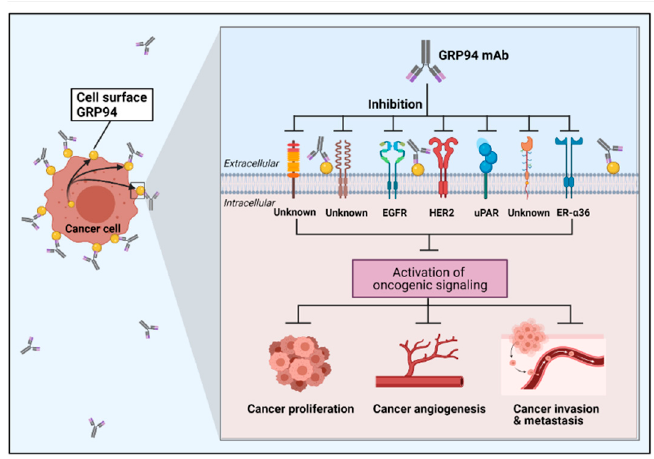
Figure 3. Schematic representation of cancer cell surface GRP94-targeting antibody, with its patho- logical role in the cancer microenvironment. GRP94 is highly expressed on the cancer cell surface. Several receptors are known for interacting with cell surface GRP94, and they facilitate cancer de- velopment by activating oncogenic signaling. So far, EGFR, HER2, uPAR, and ER- α 36 are known transmembrane receptors that require GRP94 for cancer development and activation. However, still undiscovered receptors that interact with cell surface GRP94 to promote cancer development may exist. Targeting cell surface GRP94 in cancer inhibits its interactions, resulting in the reduction of oncogenic signaling transduction, which leads to the inhibition of cancer